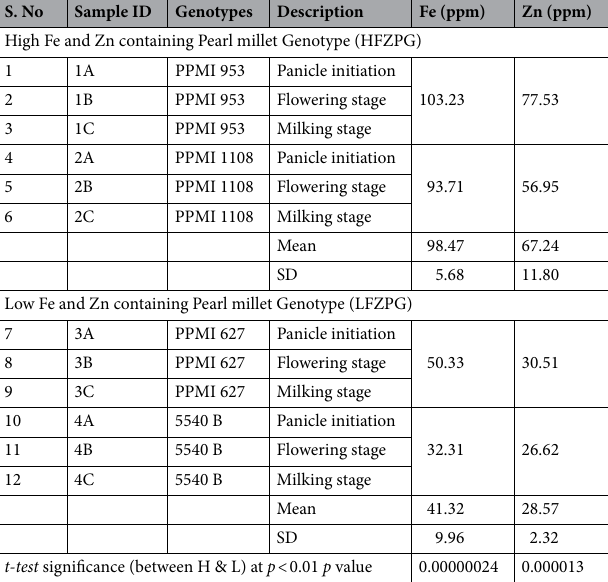
Sr. No Sample ID Genotypes